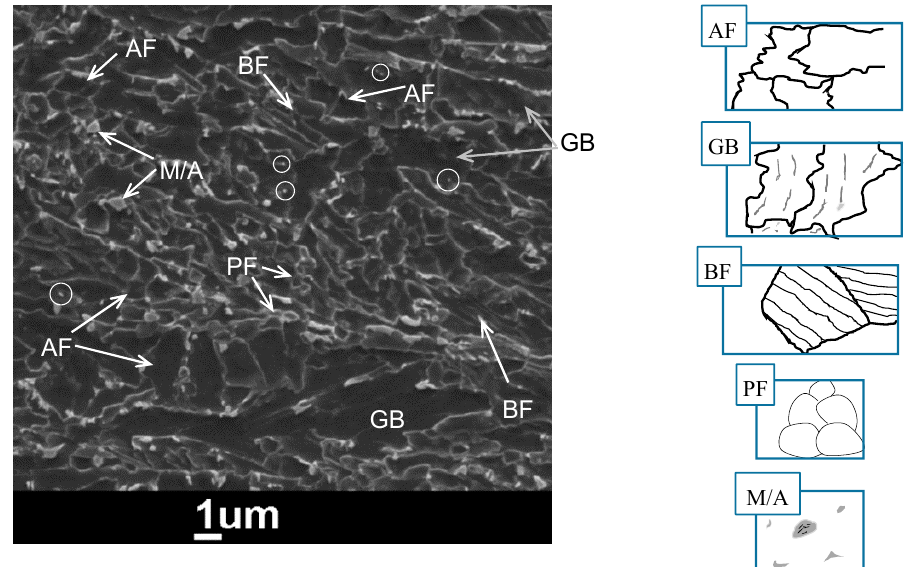
Figure3. Scanningelectronmicrographofsteelprocessedwiththeparameters:FRT = 780 ◦ C, a = 20 K · s − 1 , Figure 3. Scanning electron micrograph of steel processed with the parameters: FRT = 780 °C, a = 20 CT = 350 ◦ C together with schematic illustrations of the di ff erent obtained